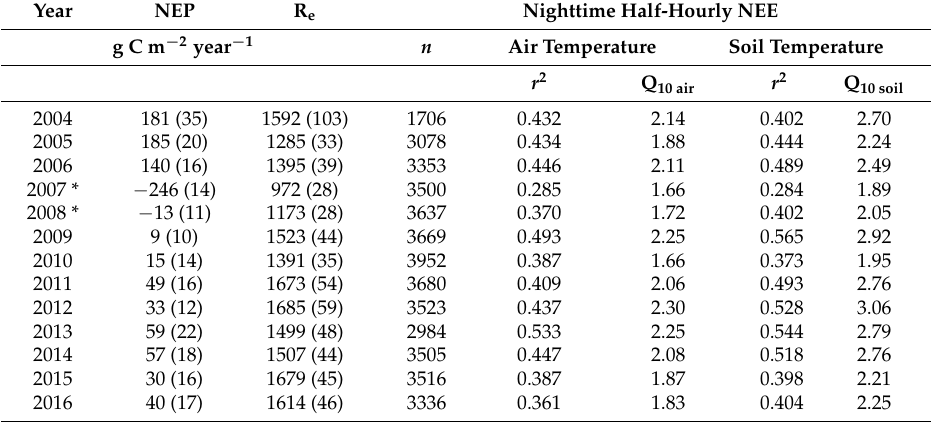
Table A1. Annual net ecosystem production (NEP), ecosystem respiration (R e ), and information for half-hourly nighttime net ecosystem exchange of CO 2 (NEE) derived from eddy covariance measurements at the oak stand. Values in parentheses for NEP are the maximum deviations from annual values as a result of gap filling using ± 1 SE parameter values derived from daytime data during the summer (1 June to 31 August) or all nighttime data, and values in parentheses for R e are the maximum deviation from annual values as a result of gap filling using ± 1 SE of parameter values derived from all nighttime data. The number of half-hourly values when u * ≥ 0.2 m s − 1 , Pearson’s product moment correlation coefficients for the modeled relationship between air or soil temperature, and temperature coefficients for air (Q 10 air ) and soil (Q 10 soil ) temperature for 10 to 20 ◦ C are shown. * indicates years when disturbance